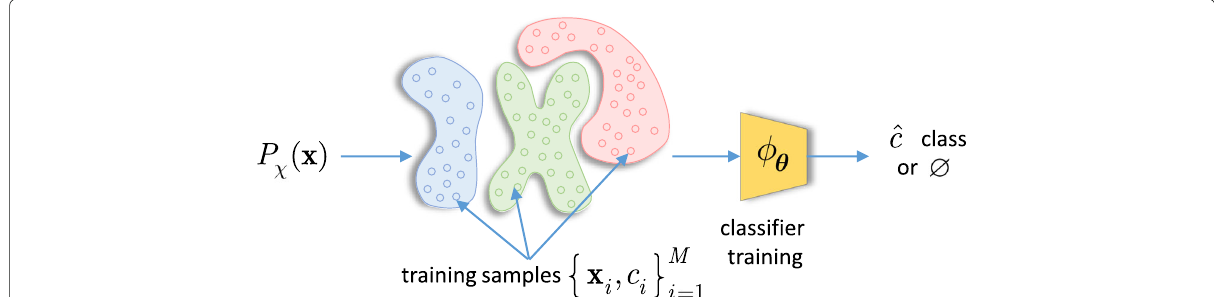
Fig. 2 Classifier training: a traditional classifier has an access to training data samples { x i , c i } M i = 1 generated from P χ ( x ) . The classifier learns a set of parameters θ to output a decision ˆ c ∈ { 1,..., M c } or to reject an input ( ∅ )